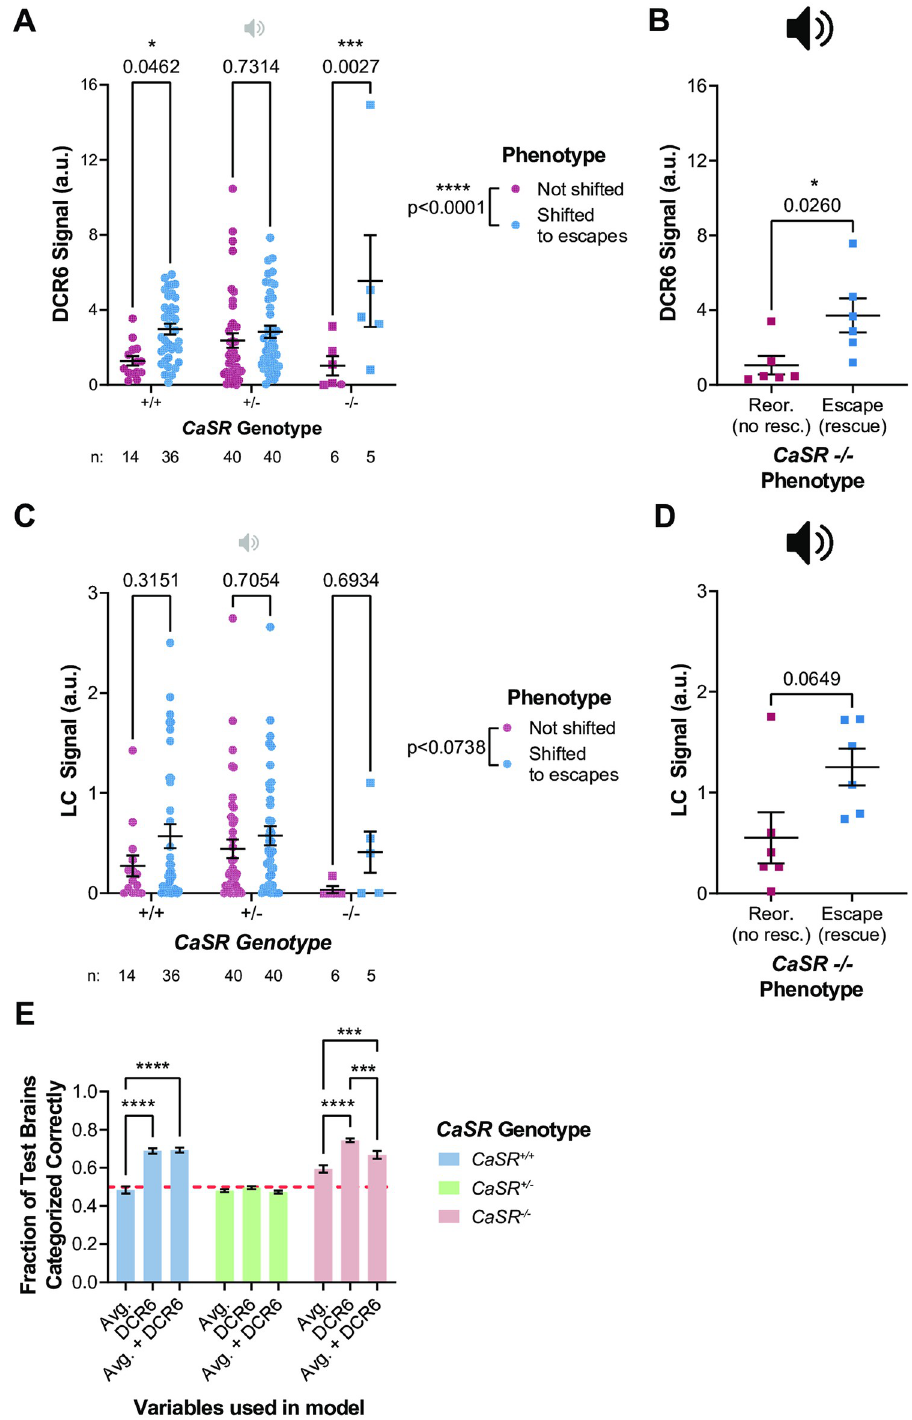
Fig 4. Identification of the Dorsal Cluster—Rhombomere 6 as a candidate site for CaSR-dependent decision- making. A) Normalized fluorescence intensity signal in the DRC6 of larvae of various CaSR genotypes that either displayed the typical phenotype (red) or were escape-shifted (phenotype caused by CaSR overexpression) (blue) in response to a low-intensity, primarily reorientation-evoking stimulus. Presence of the overexpression phenotype significantly (p < 0.0001) predicts DCR6 signal by Two-way ANOVA. B) Normalized fluorescence intensity signal in the Dorsal Cluster–Rhombomere 6 of CaSR mutants whose behavioral phenotype was unrescued (red) vs rescued